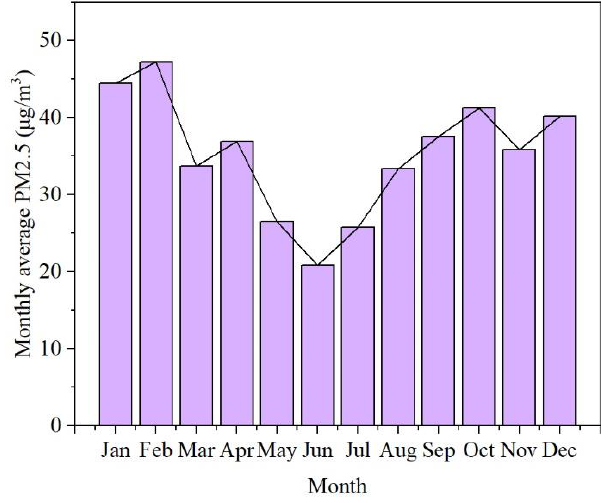
Figure 3. Monthly average concentration of PM 2.5 in Guangzhou from January to December 2015.